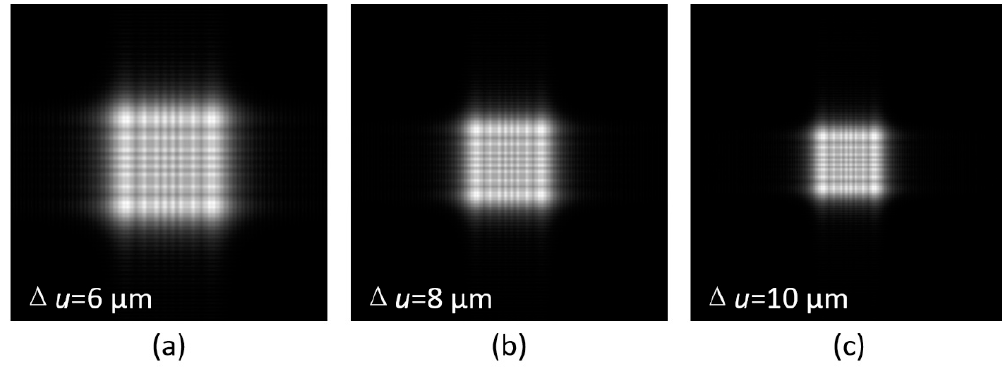
Figure 2. Shifted Fresnel diffraction with different scale factors: ( a ) Δ u = 6 μ m, ( b ) Δ u = 8 μ m, ( c ) Δ u = 10 μ m.